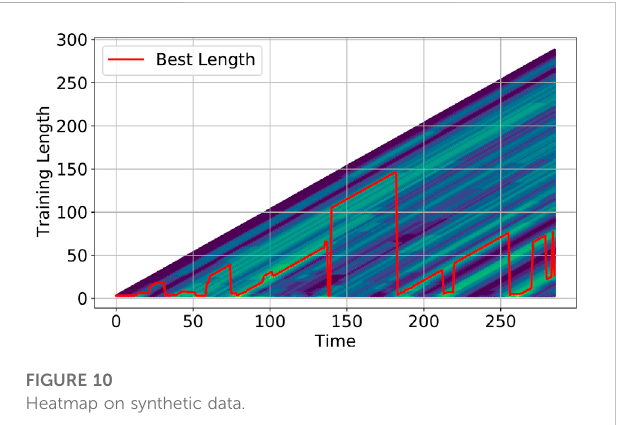
FIGURE 10 Heatmap on synthetic